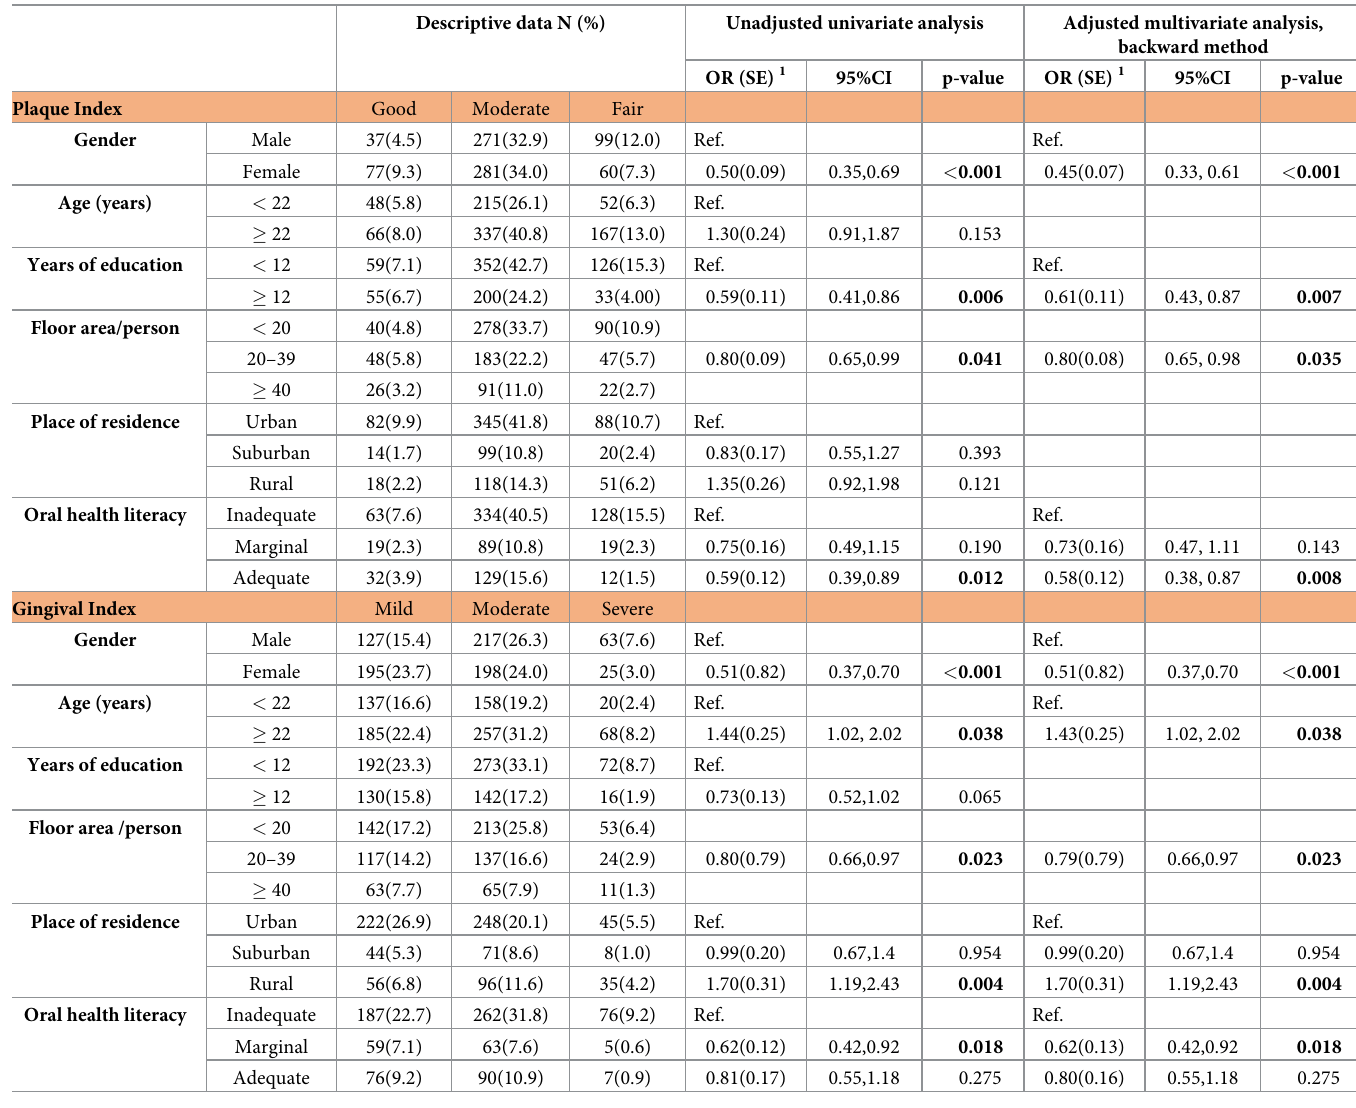
Table 3. Oral health literacy, demographic characteristics and their relationship with oral hygiene and gingival health status of the participants